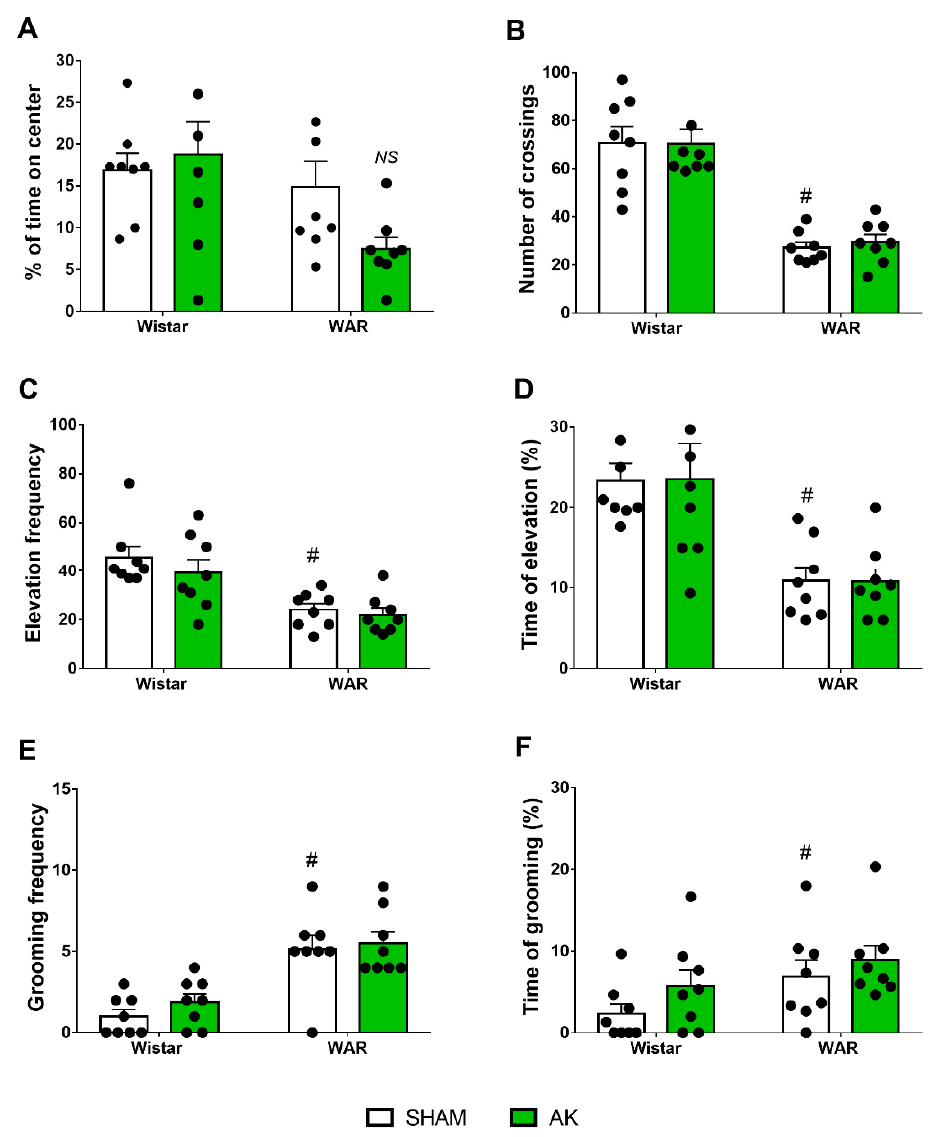
Figure 3. Assessment of anxiety-like behavior in the open-field (OF) test. The measures analyzed were ( A ) percentage of time in the center, ( B ) the number of crossings, ( C ) frequency of elevation, ( D ) time of elevation, ( E ) frequency of grooming, and ( F ) time of grooming. The behavioral tests in the OF were performed during 5 min on the 11th experimental day. # p < 0.05 Tukey test comparing WAR-Sham and Wistar-Sham groups. NS = non-significant difference. Data are expressed as means ± standard error mean. N = 8/group.